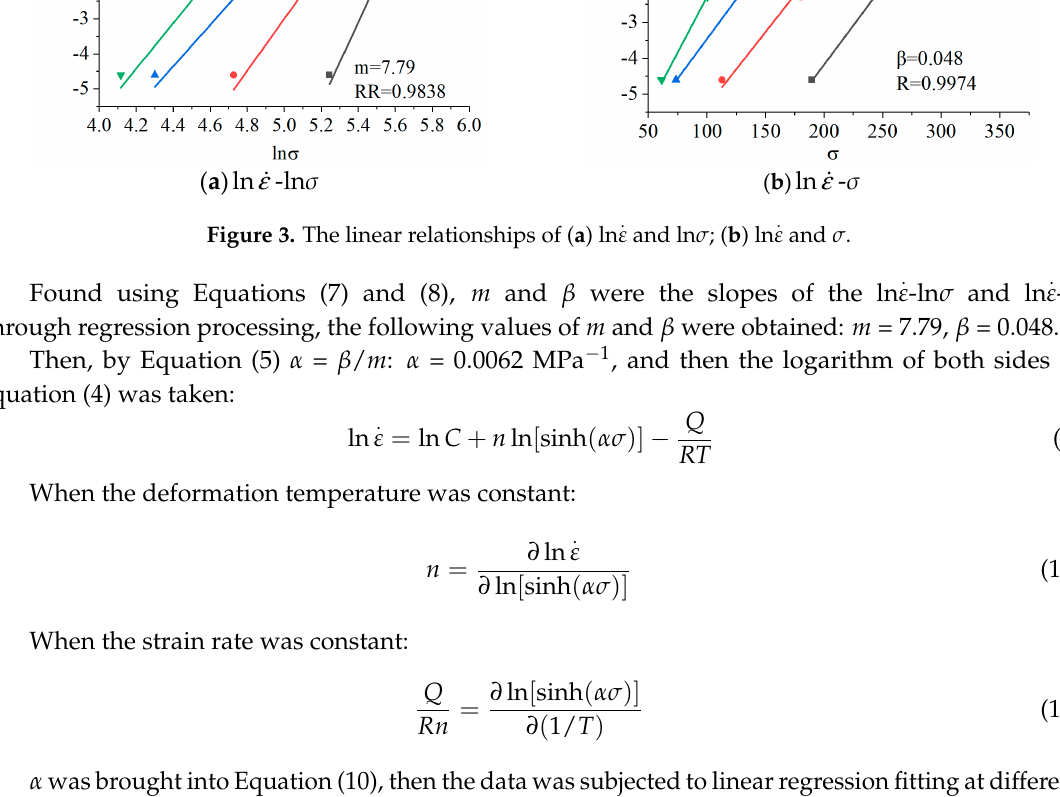
Figure 3. The linear relationships of ( a ) ln  ε and ln σ ; ( b ) ln  ε and σ .